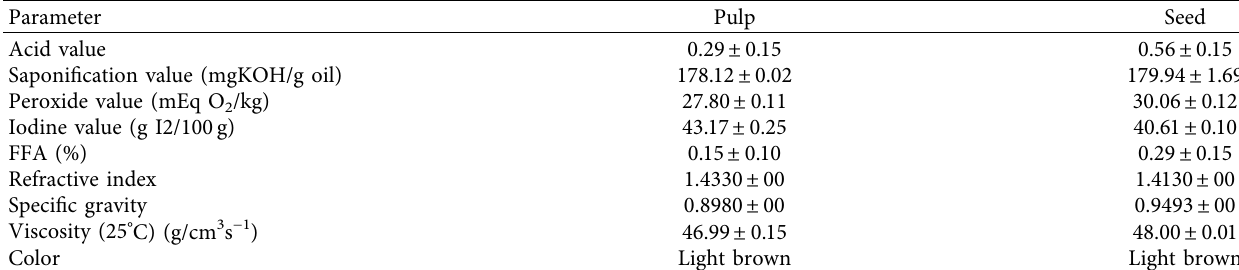
Table 2: Physicochemical properties of the oil extracted from X. americana pulp and seed.